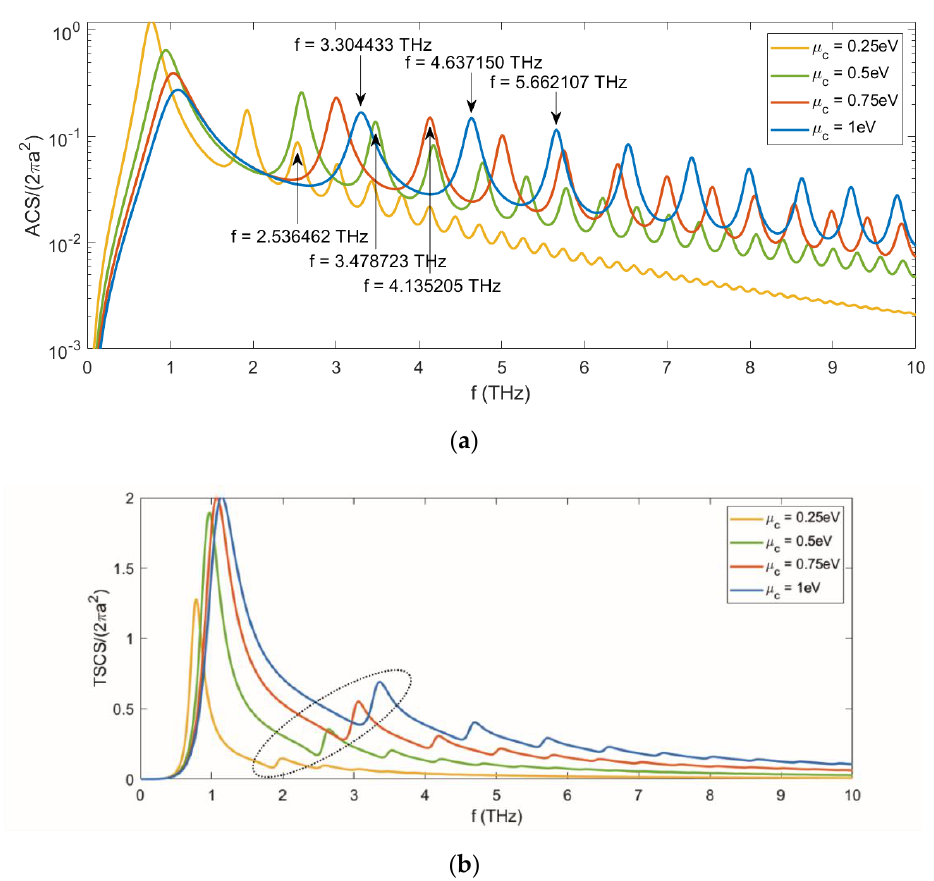
Figure 2. Normalized ACS and TSCS of the graphene disk with a = 50 µ m, T = 300 K, t relax = 1 ps, µ c = 0.25 eV, 0.5 eV, 0.75 eV, 1 eV , for varying values of the frequency ( f ) when a plane wave orthogonally impinges onto the disk. ( a ) Normalized ACS; ( b ) Normalized